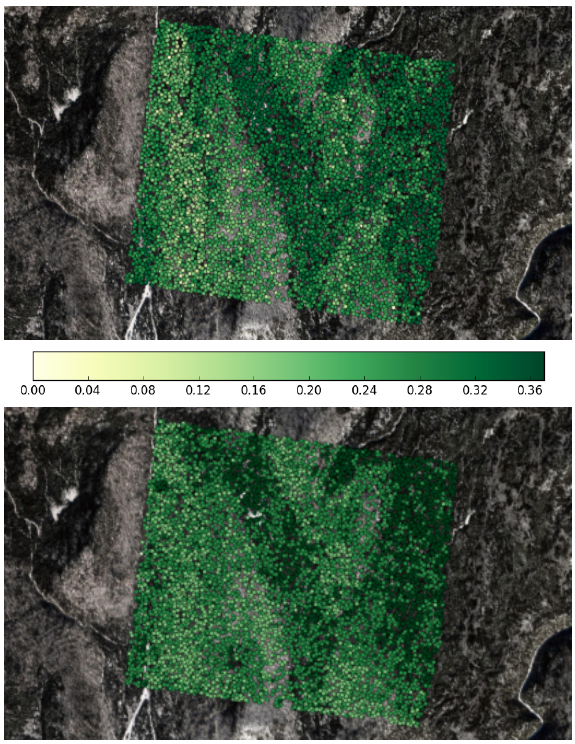
Figure 22. Estimation of canopy cover. Top : classification by LIDAR; Bottom : classification achieved from SAR after